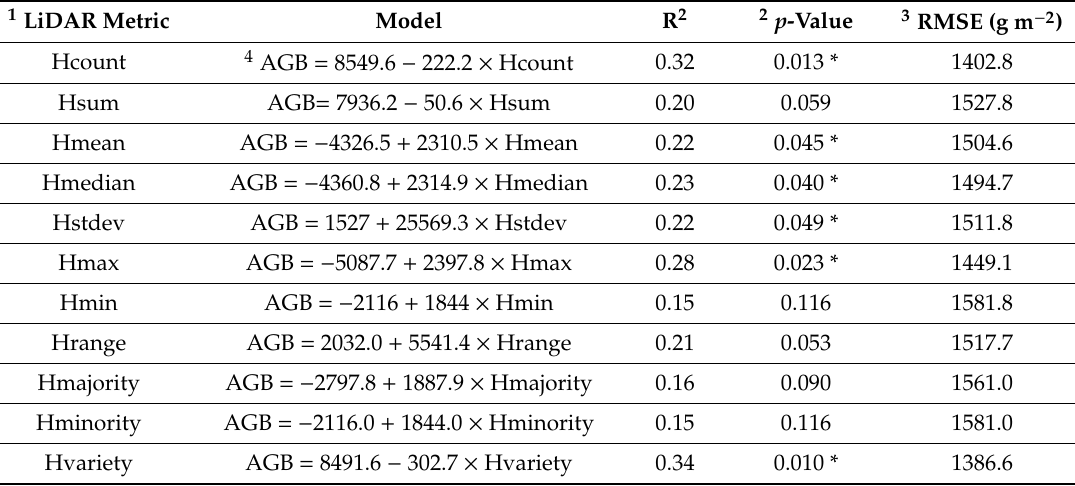
Table 2. Measuring the ability of light detection and ranging (LiDAR) metrics in estimating above-ground biomass (AGB) using simple linear regression.